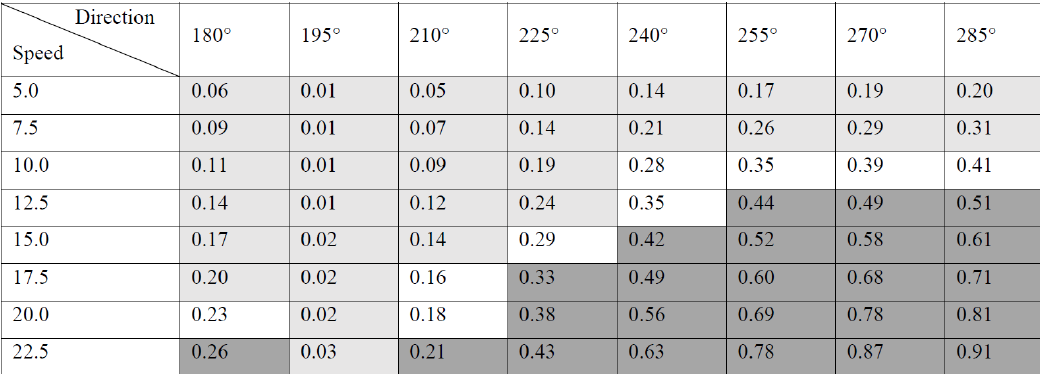
Figure 5. The distributions of pressure (hPa, isobars, every 1hPa), streamlines, and wind speed (ms − 1 , color) at the height of 1481m every 8h from (a) 0h to (f) 40h in the CTL experiment. The height contours at 1481m (gray) are also drawn. In Taiwan, the LST is UTC + 8h. Table 3. The values of moist Froude number ( Fr w ) in the experiment set with prescribed southwesterly wind direction ( ◦ , column) and speed (ms − 1 , row). Cells filled with light gray indicate a rainfall regime mainly from island circulation (with lower Fr w ), and those filled with medium gray indicate a regime dominated by terrain uplift (with higher Fr w ), based on the simulated daily rainfall pattern over Taiwan. The cells with no color indicate mixed rainfall from both